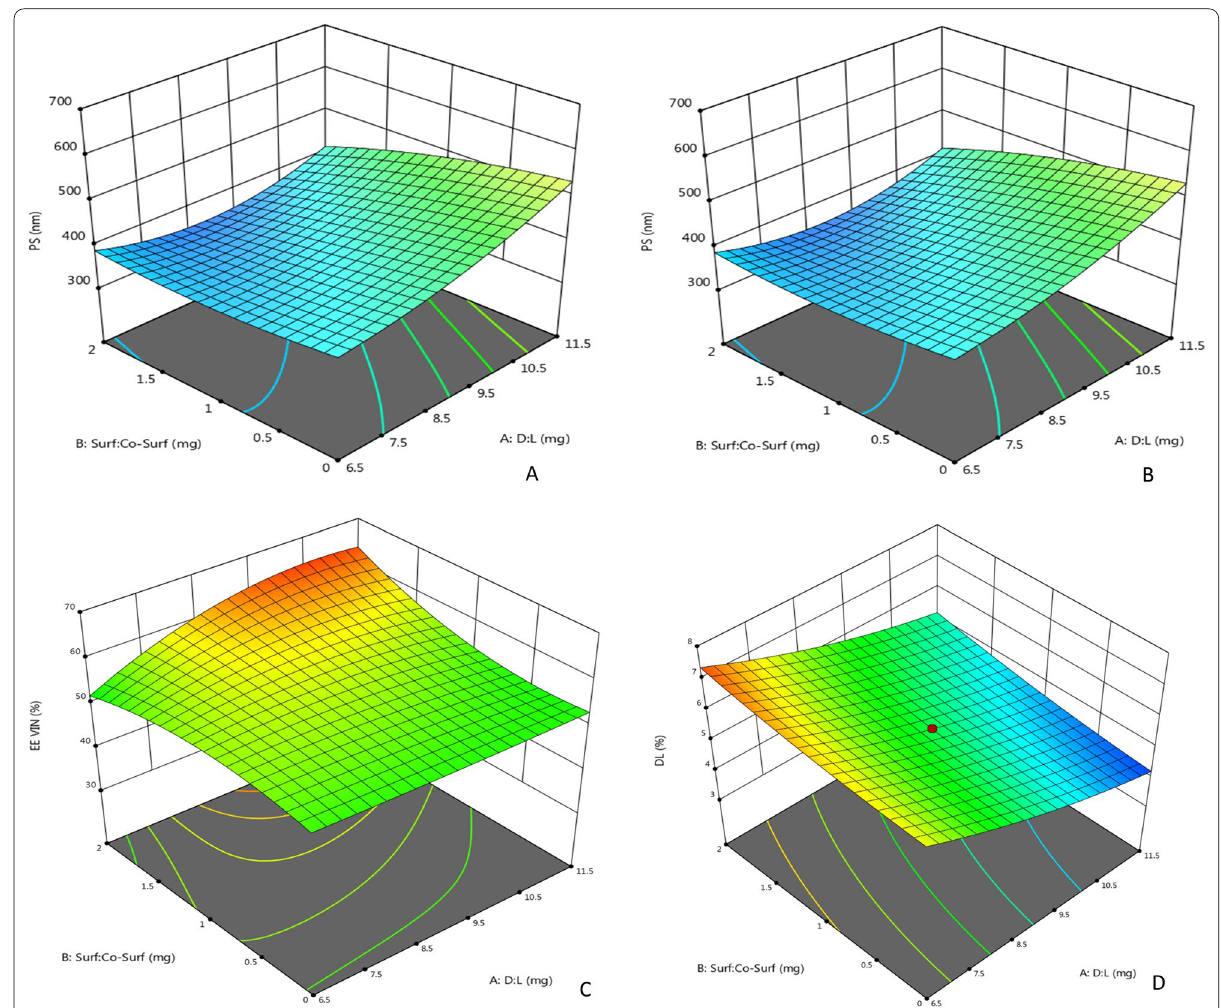
Fig. 1 Response surface plot of a particle size, b EE (ATS), c EE (VIN), d DL